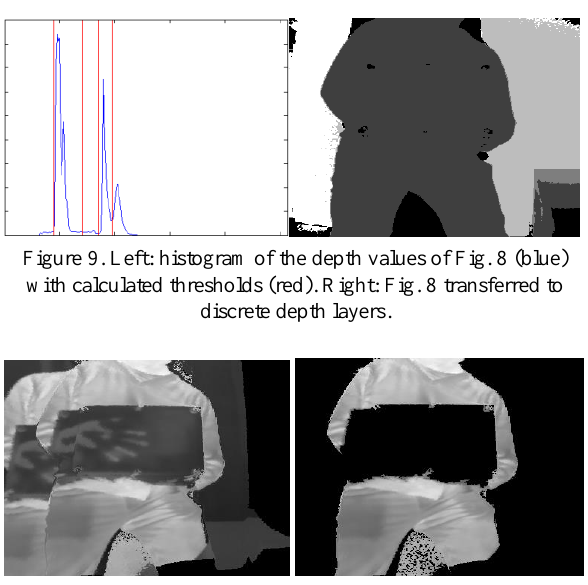
Figure 10. Left: 3d points seen by the TOF camera with TIR intensities. Right: Person detection result with background and suitcase removed